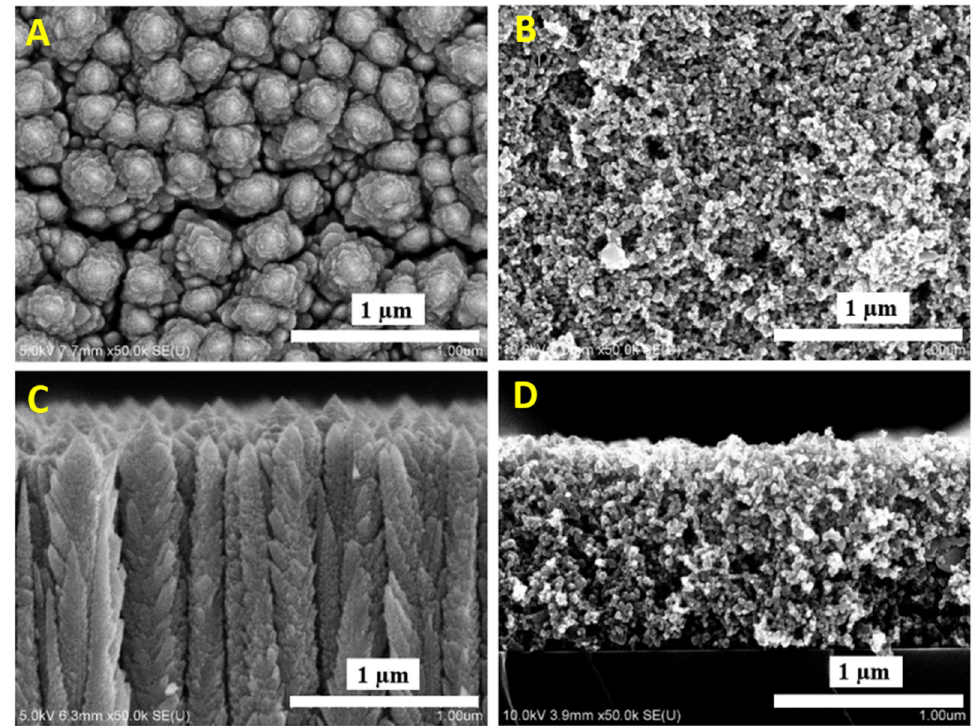
Figure 3. SEM micrographs of TiO 2 layers. ( A , C )—top view and cross-section of TiO 2 Spikelet layer; ( B , D )—top view and cross-section of TiO 2 P25 reference layer, respectively. SEM